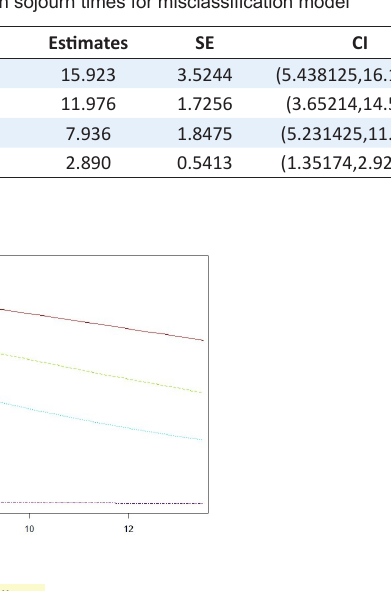
Figure 2 . Plot of fitted survival